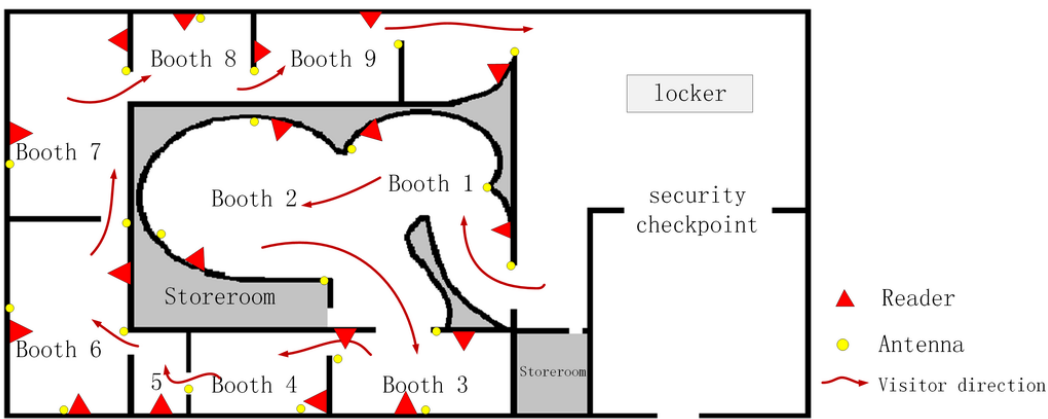
Figure 10. Vertical view of the large venue. Sensors 2020 , 20 , x FOR PEER REVIEW